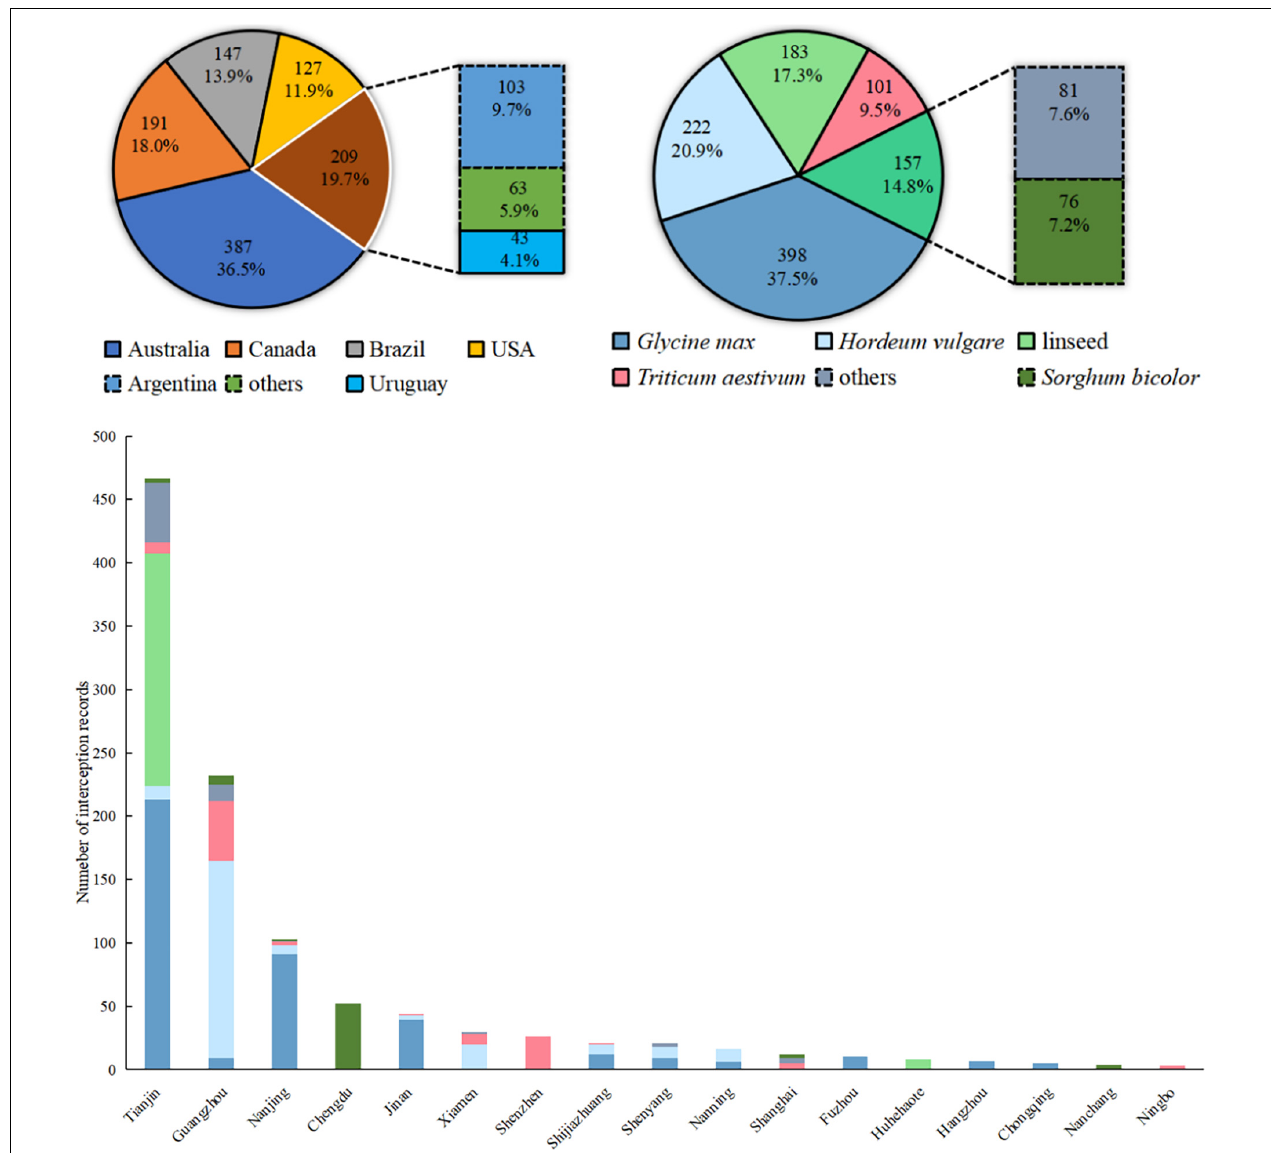
FIGURE 6 | Imported commodities, countries of origin, and customs with interception records of Rapistrum rugosum in China during